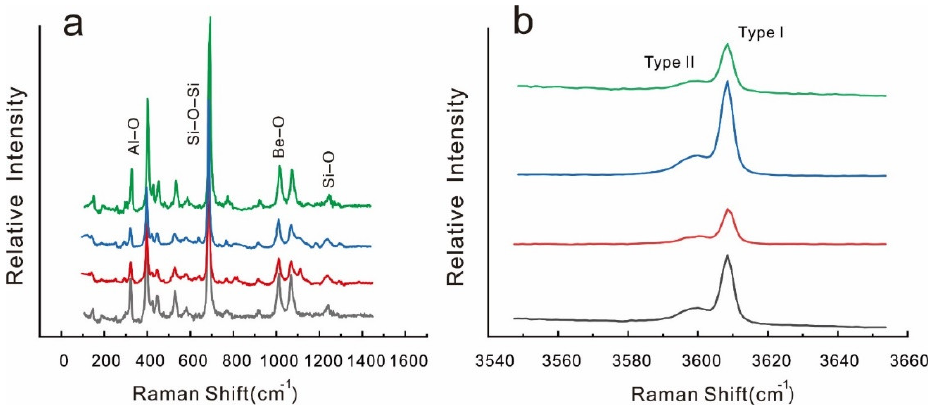
Figure 6. ( a ) Raman spectrum of Longzi aquamarine. ( b ) Tunnel water Raman spectrum of Longzi aquamarine.